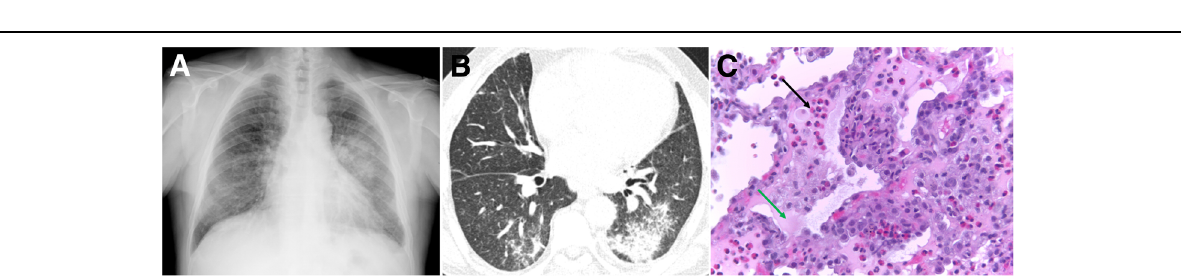
Fig. 9 Radiologic-pathologic correlation of AEP. a Posteroanterior (PA) radiograph shows bilateral ground-glass opacities and consolidation in the mid-left lung zone. A small left pleural effusion is present. b Axial CT shows peripheral lower lobe consolidations and ground-glass opacities, mainly on the left. c Transthoracic lung biopsy showing eosinophils (black arrow) infiltrating the interstitium and the alveolar spaces; edema (green arrow) and reactive pneumocytes are seen; no necrotizing vasculitis is observed (H&E, × 400)